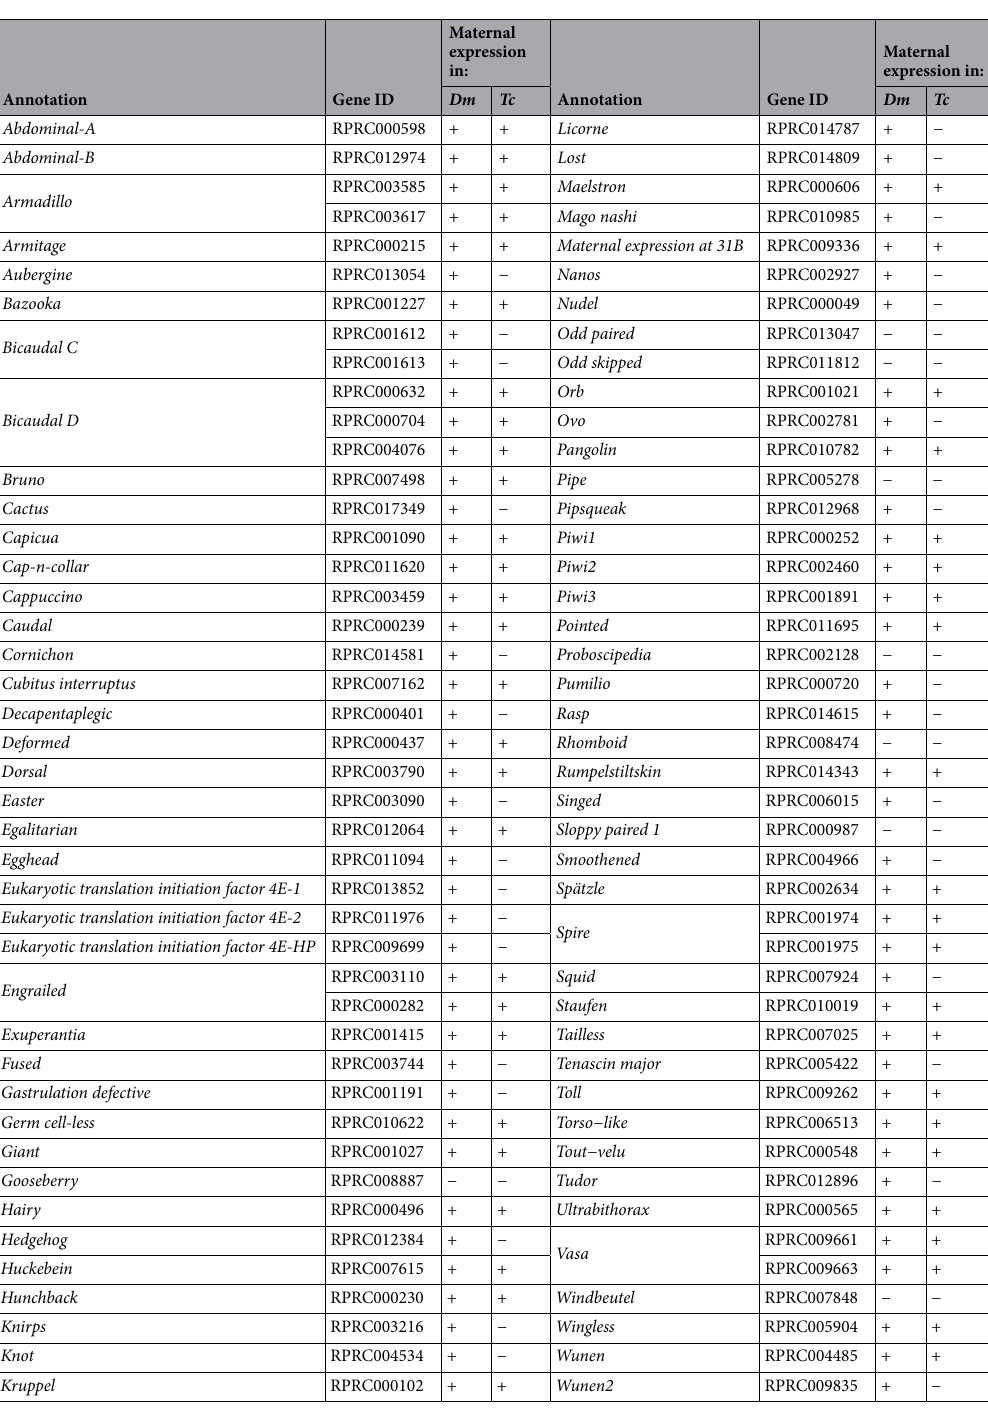
Table 4. Annotated developmental genes identified as maternal gene in R. prolixus. + : detected with maternal expression; − : not